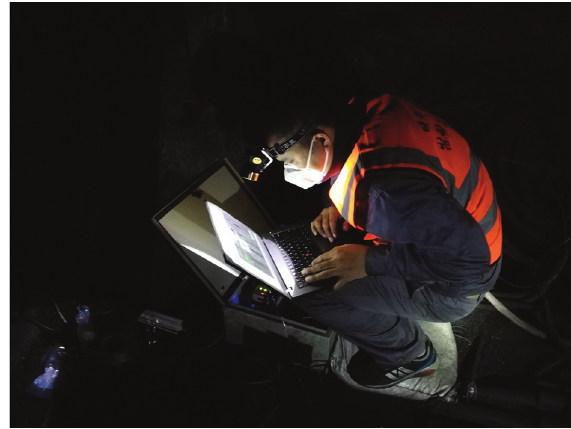
Figure 5: Equipment commissioning.